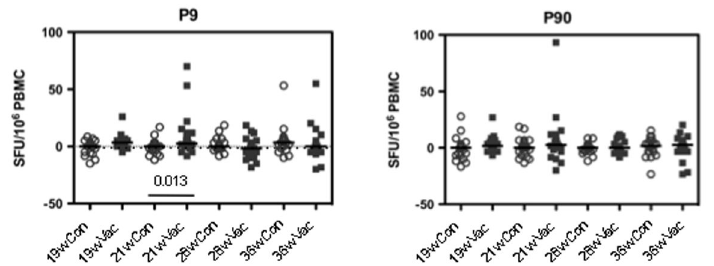
Figure 3. MVA.HIVA-elicited weak T-cell responses in fresh IFN-γ ELISPOT assay. The net fresh ex-vivo ELISPOT frequencies of IFN-γ-producing cells (mean of stimulated wells minus mean of negative control wells) to HIVA peptide pools P9 and P90 at all 4 bleed time points for the control (Con) and vaccinated (Vac) groups are shown. The p value for the only statistically significant difference between the two groups after Bonferroni correction is given. The median ‘mock’ no-peptide background response across all wells on plates that passed QC was 5 SFU/10 6 PBMC (IQ range 0-20), and median PHA response was 1,850 SFU/10 6 PBMC (IQ range 1,065- 2,960).